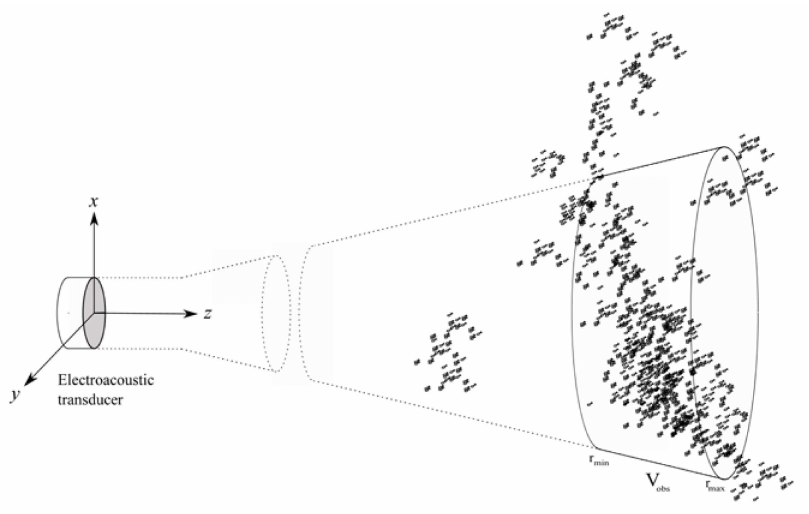
Figure 5. Sketch of the acoustic system under analysis, with an electroacoustic transducer operating as a transmitter and receiver of ultrasound, and acoustic volume backscattering from a multitude of scattering objects in a spherical shell observation volume, V obs . (Reproduced from [22], with permission from the Institute of Marine Research,